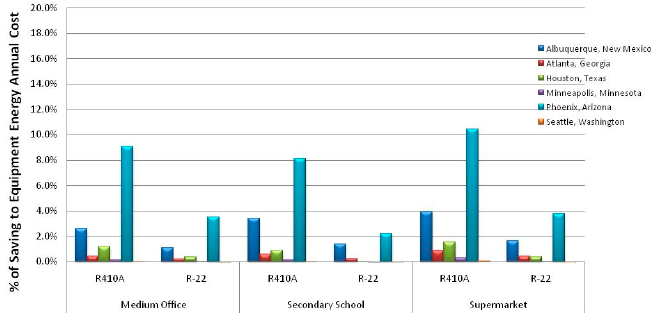
Figure 14. Percentage of energy savings due to pre-cooling relative to no pre-cooling at all ambient temperatures. Wet bulb efficiency = 0.9, equipment COP = 5.